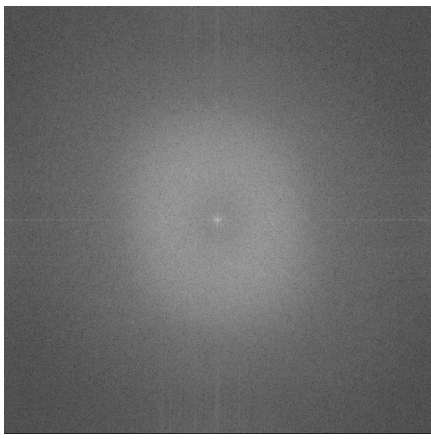
Fig. 4. Binary images.